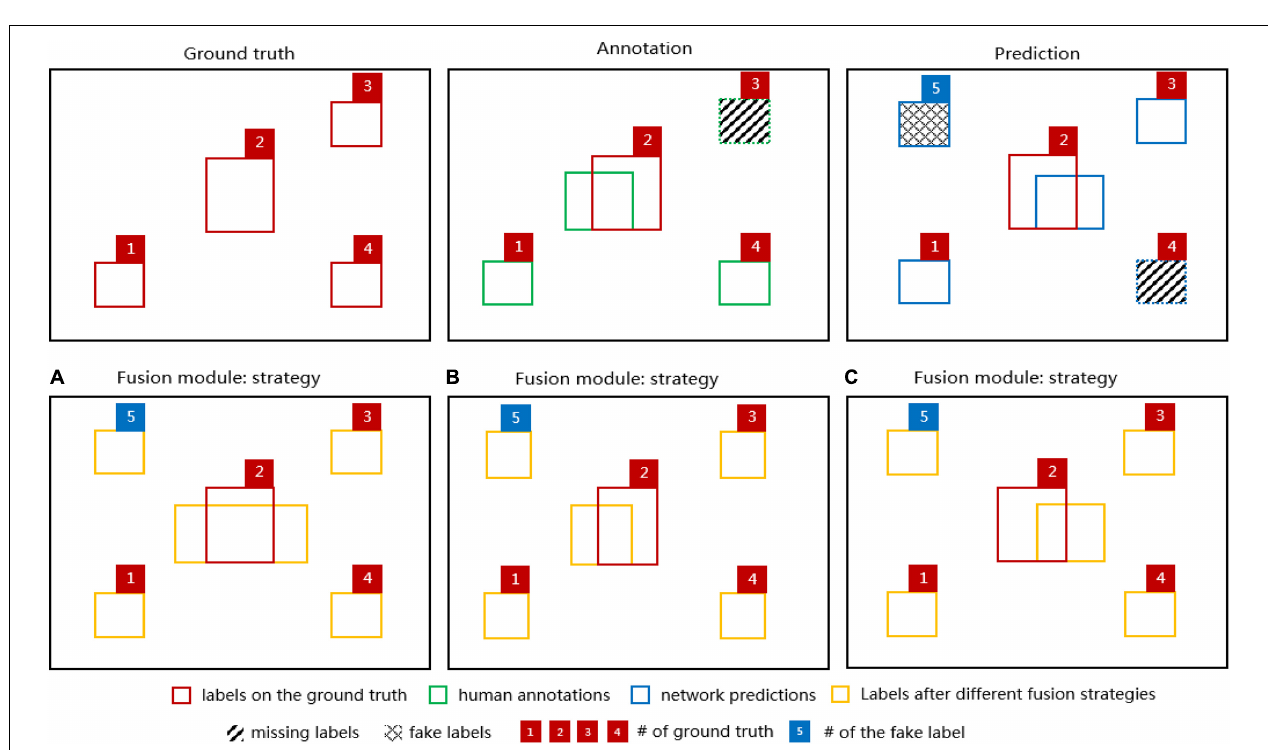
FIGURE 4 | A frame of the MOST image stack (A) with the corresponding annotations for somata (B) , and vessels (C) . Red boxes numbered 1 and 2 in panel (A) mark vessel structures that were missed in human annotations (as pointed out by red arrows) in panel (C) , and green boxes numbered 3 and 4 in panel (A) mark soma structures that were annotated as overlapping labels (as pointed out by green arrows) in panel (B) .